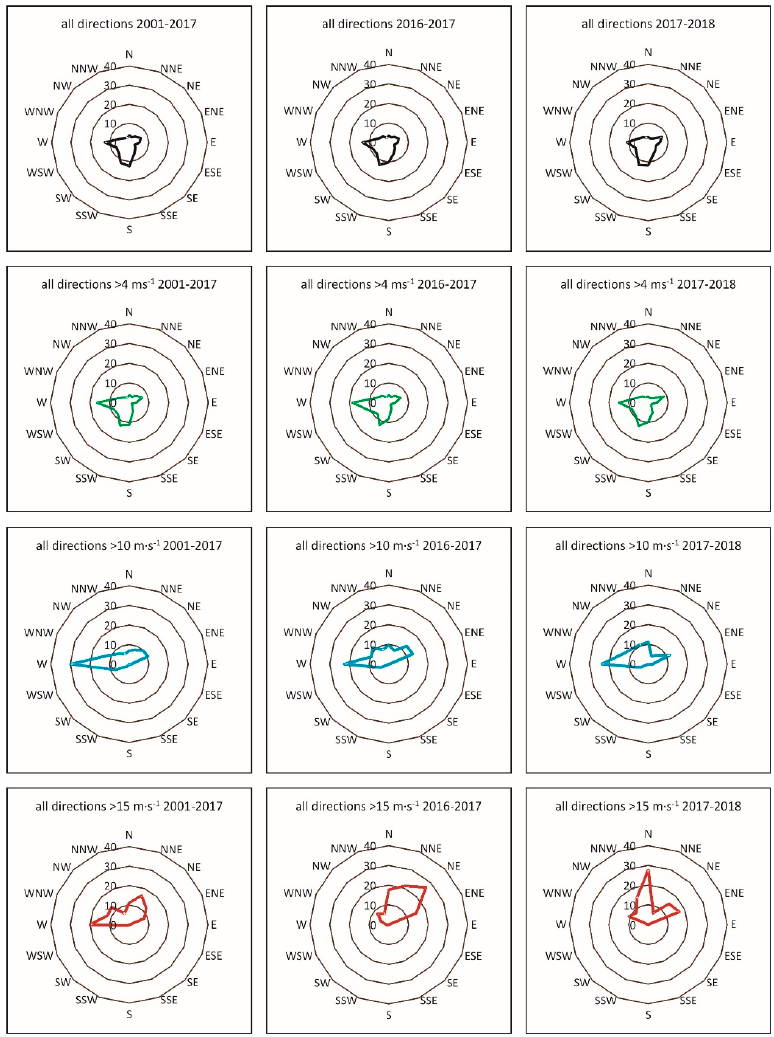
Figure 5. Percentage of all wind directions in the years 2001–2017 and in the long-term period of In 2001–2017, the number of days with wind speeds fostering aeolian processes was differentiated. For respective wind speeds, the average number of days was respectively: 260, 94, and 16 (Table 1). Table 1. Number of days with wind speeds allowing aeolian transport in 2001–2017.